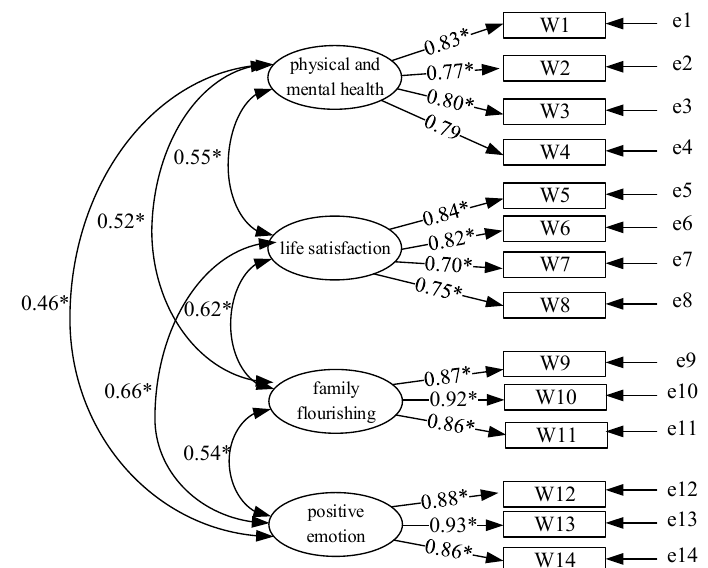
Figure 1. Recreational Sport Well-being Scale’s CFA Analysis Model. * p < 0.05.